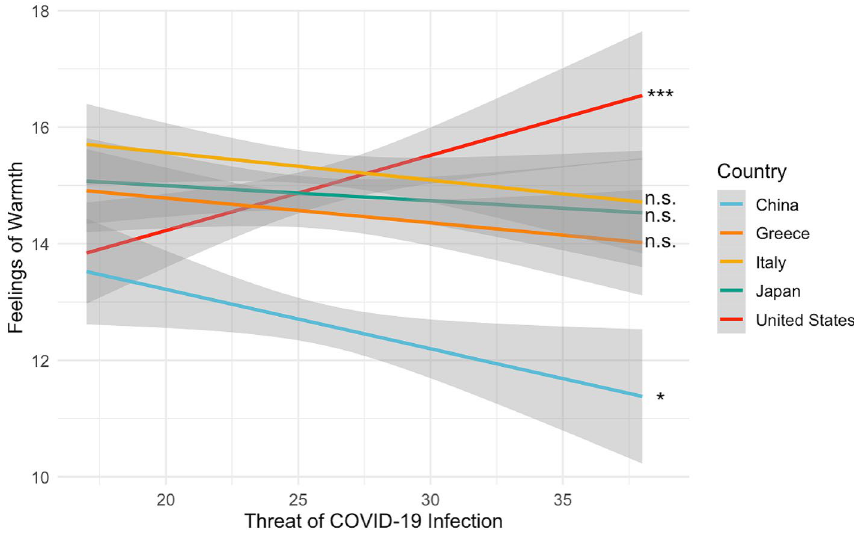
Figure 1. Perceived risk of COVID-19 infection is associated with greater warmth toward American nationals, less warmth toward Chinese nationals, and is unrelated to warmth felt toward all other groups considered.